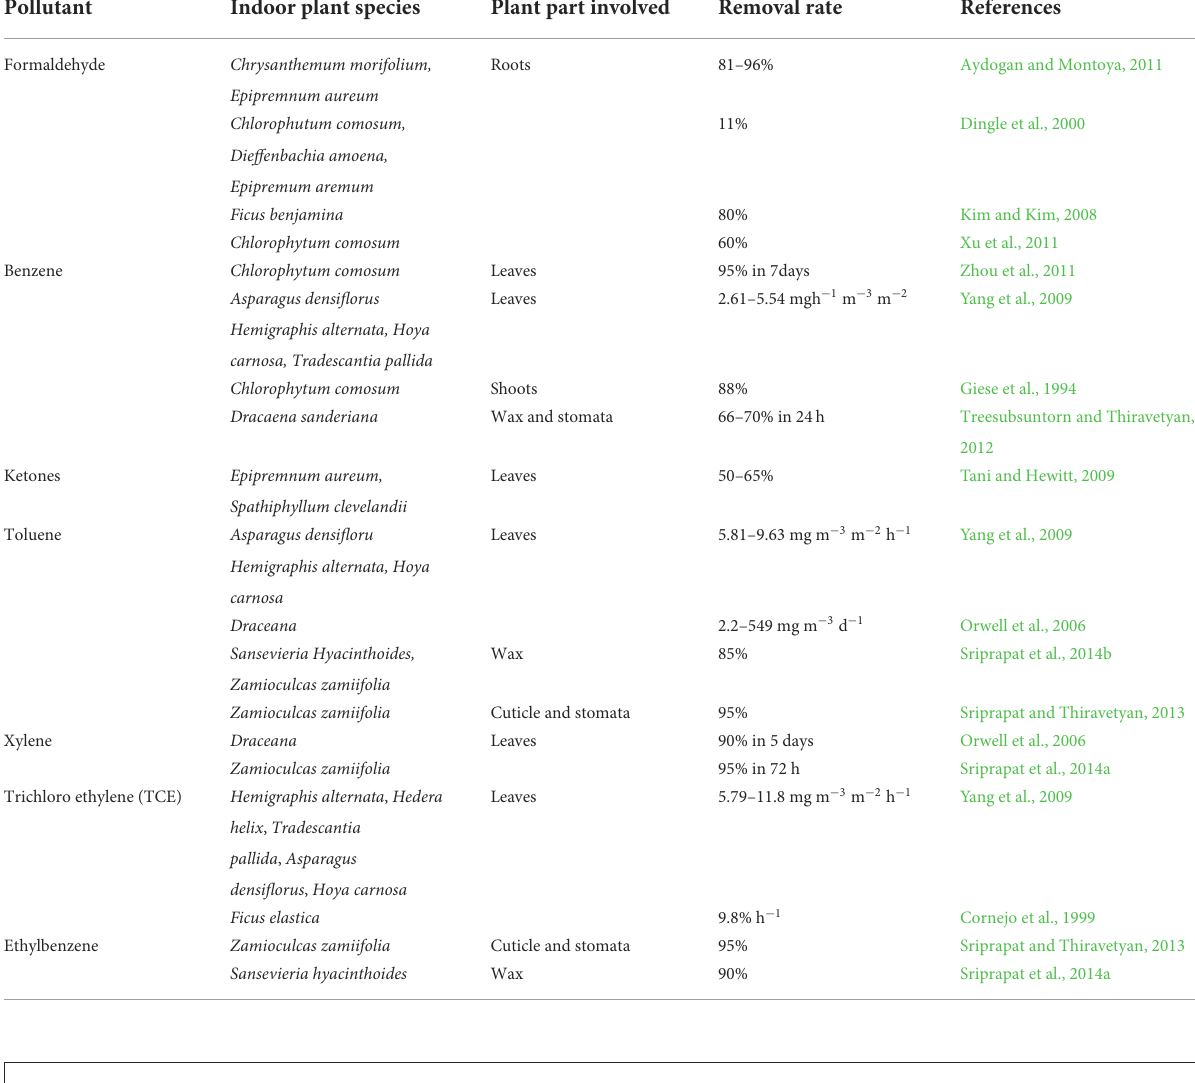
TABLE 3 List of indoor plants and their parts involved in air pollutant removal.